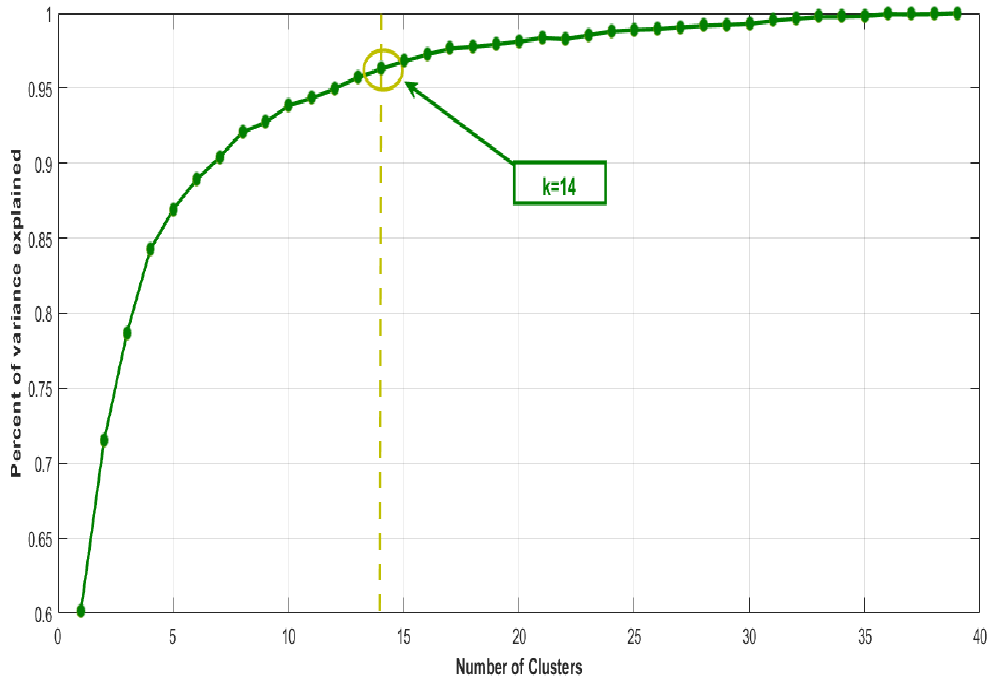
Figure 8. Application of k-means to C 10 circuit with Elbow